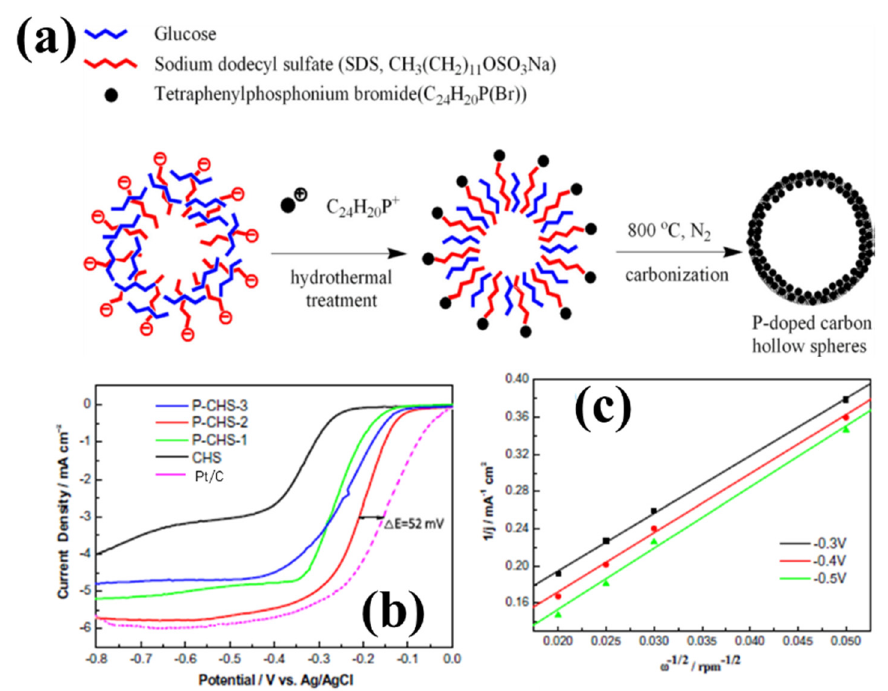
Figure 7. ( a ) Schematic illustration of the preparation of P–doped carbon hollow spheres, ( b ) linear sweeping voltammograms of the ORR on the samples with a rotating speed of 1600 rpm, ( c ) the K– L plots of ORR on PCHS–2 at different electrode rotating speeds, adapted from